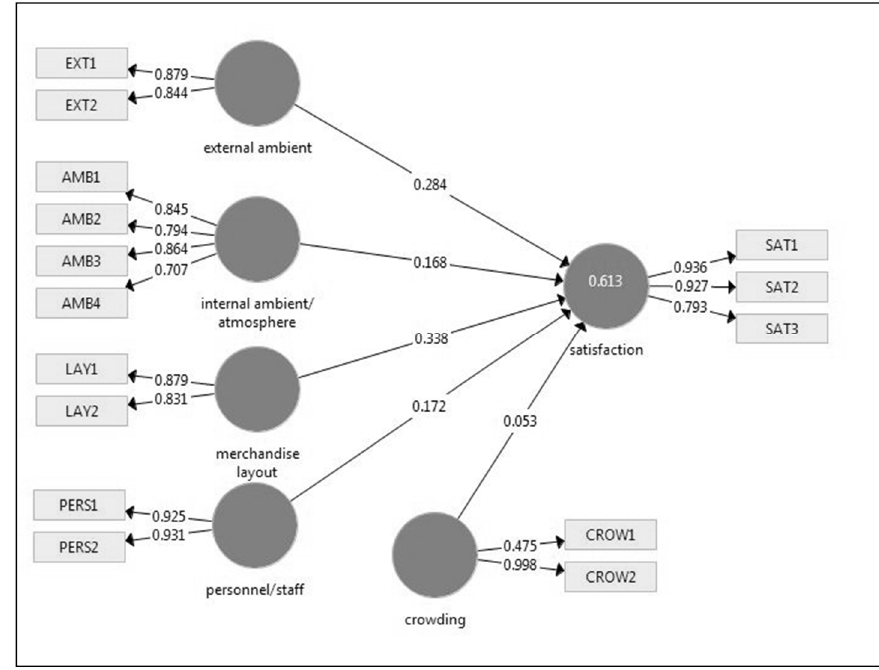
Figure 3. Results of the path analysis (utilitarian shopping).